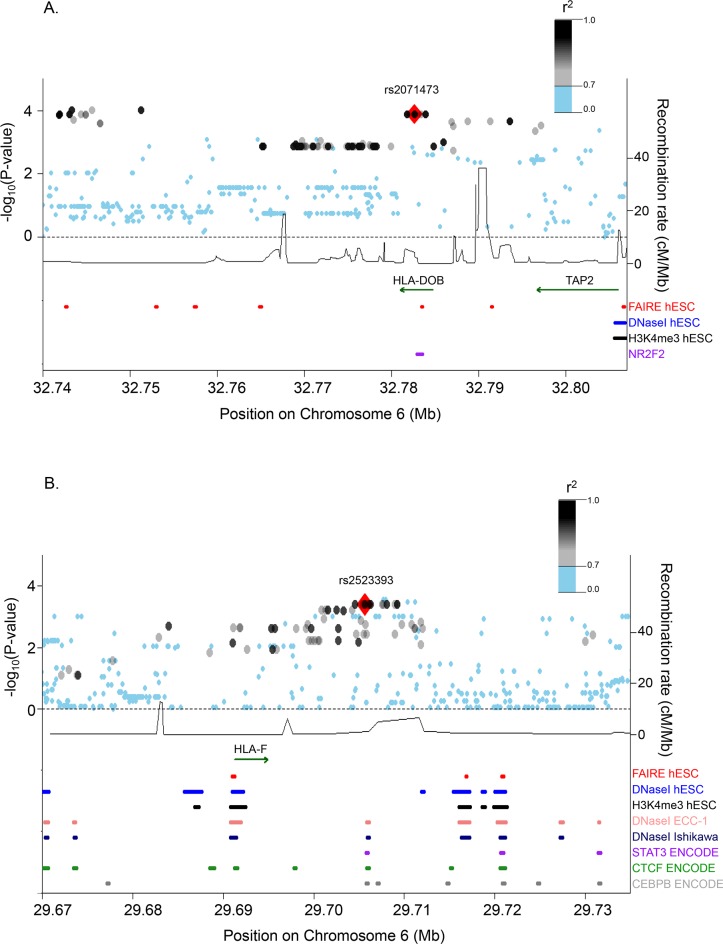
Regional associations with fecundability and functional annotations of the TAP2 locus (Panel A) and the HLA-F locus (Panel B). The lead eSNP at each locus is shown as a red triangle; all other variants are color-coded based on their LD with the lead eSNPs. The upper section of each figure shows associations between variants within 6 kb of rs2071473 (A) or rs2523393 (B) and fecundability (left y-axis) and local recombination rates (right y-axis). The lower section of each figure shows the location of experimentally validated regulatory sites. Only genes that were detected as expressed in our eQTL study in mid-secretory endometrial cells are shown above the functional annotations. hESC, human endometrial stromal cells [23].